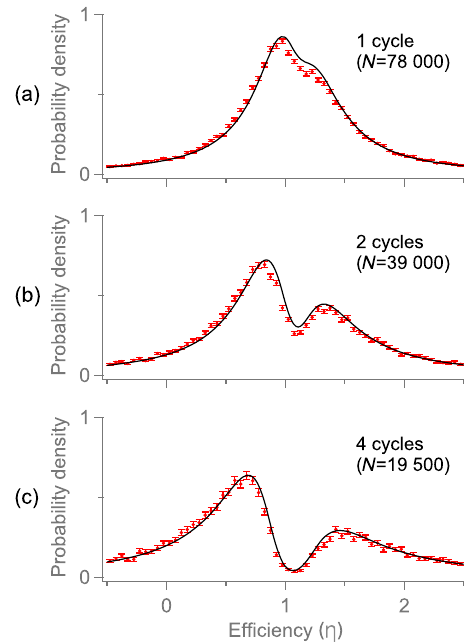
FIG. 4. Efficiency distributions for symmetric driving. The solid lines show the theoretical probability densities, calculated — not fit — from Eqs. (20) and (21). Error bars are calculated as the square root of counts in each histogram bin. Figure (a) shows the probability density for 1 cycle, (b) for 2 cycles and (c) for 4